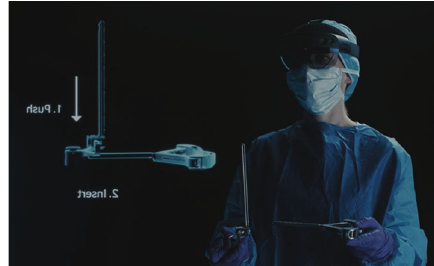
Figure 1: The HoloLens 2 mixed-reality headset is used in visual instrumentation setup in this example of using a holographic display. Used with permission from Zimmer Biomet, Inc.